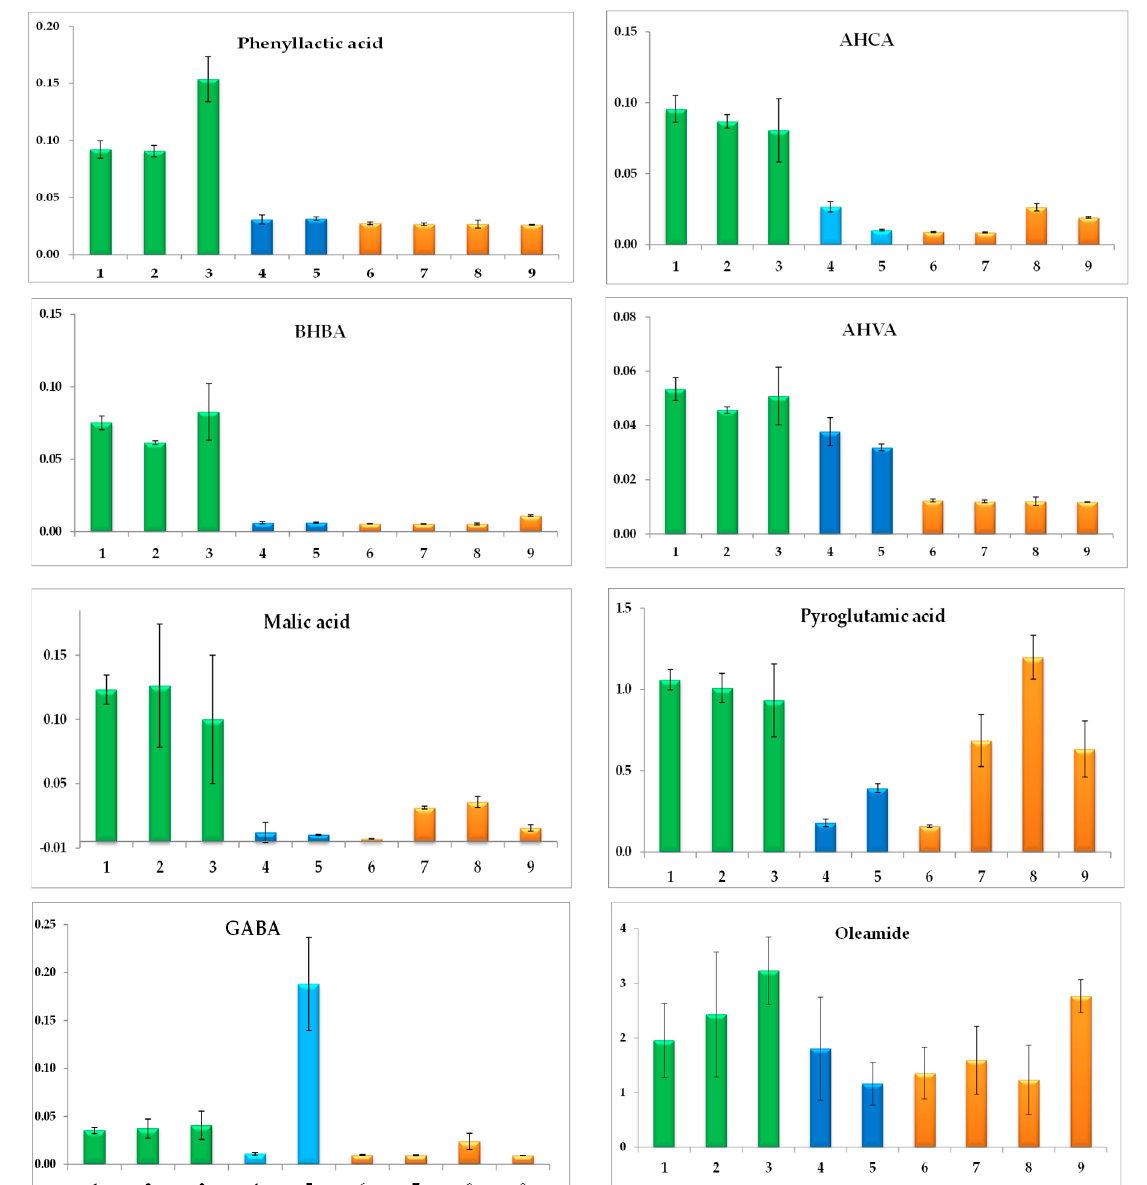
Figure 2. Relative abundance of metabolites in each strain: green L. plantarum (1 = 1/14537, 2 = 4/16898, 3 = C1/15); light blue L. brevis (4 = DSM 32516, 5 = M8/1 S4); yellow L. sakei (6 = S4, 7 = S3, 8 = S3/1, 9 = S5). Y-axis values are in A.U. and refer to the intensity of a selected m / z ion fragment. Abbreviation of metabolites as in Table S2.